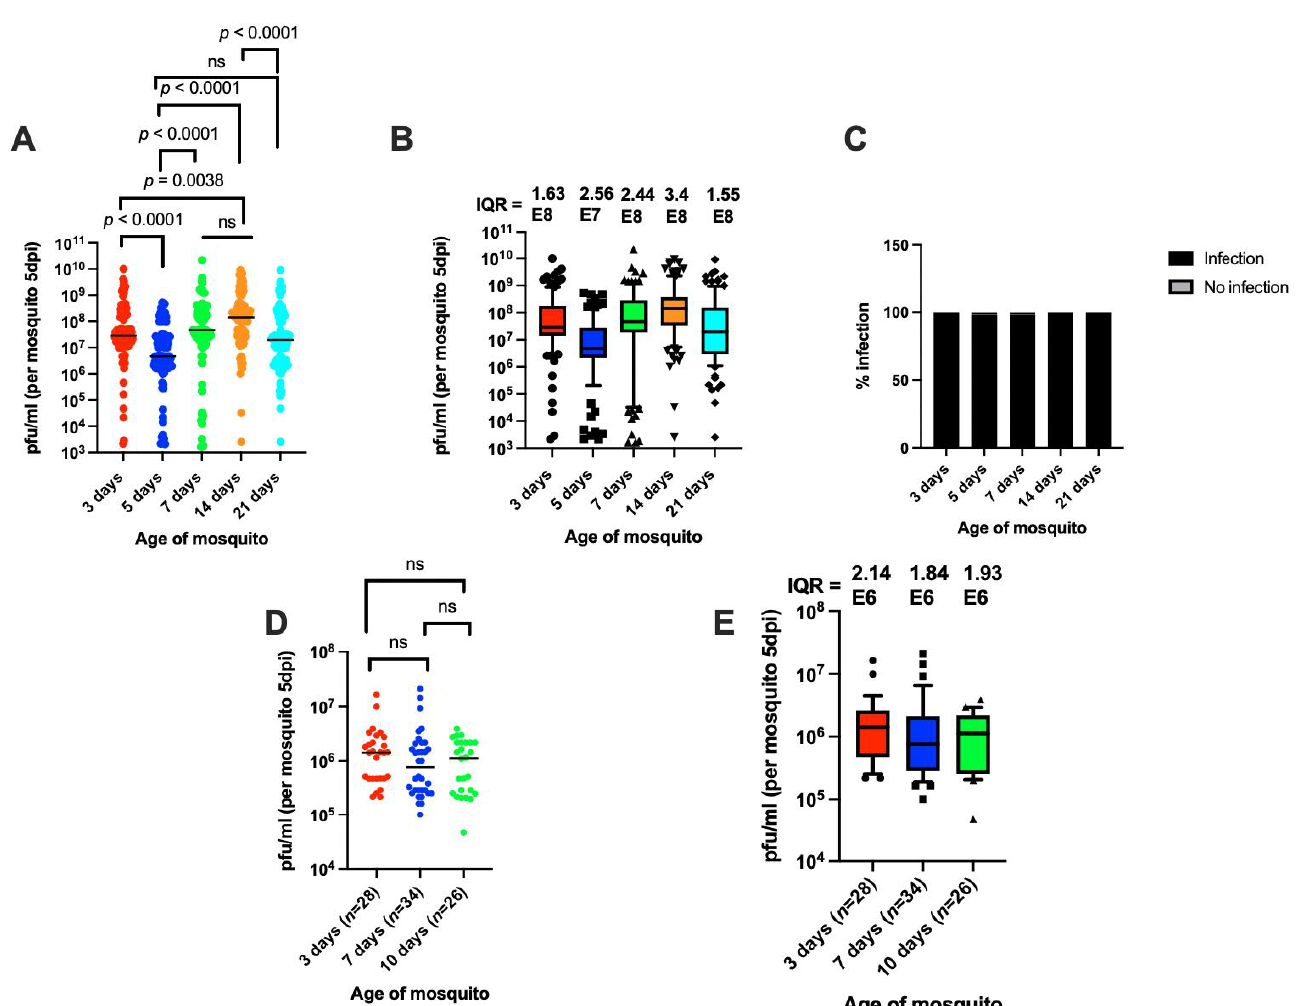
Figure 2. Oral and intrathoracic infection of Ae. aegypti adults of different ages (days post-emergence). ( A ) Titers of mosquitoes of different ages at 5 days PBM. ( B ) The use of IQR as a measure of variation. The dataset used in panel B is the same as in A. ( C ) Prevalence of infection of mosquitoes of different ages after oral infection. Sample size in ( A – C ) was 100 per treatment. ( D ) Titers of mosquitoes of different ages at 5 days after intrathoracic infection. ( E ) The use of IQR as a measure of variation. The dataset used in panel ( D ) is same as in ( E ). Sample size in ( D , E ) is shown below the graphs. Kruskal – Wallis test was used for statistical analysis in ( A , D ), while Dunn ’s test was used for multiple comparison in ( A ). Chi-square test was used for analysis in ( C ). ns, non-significant.